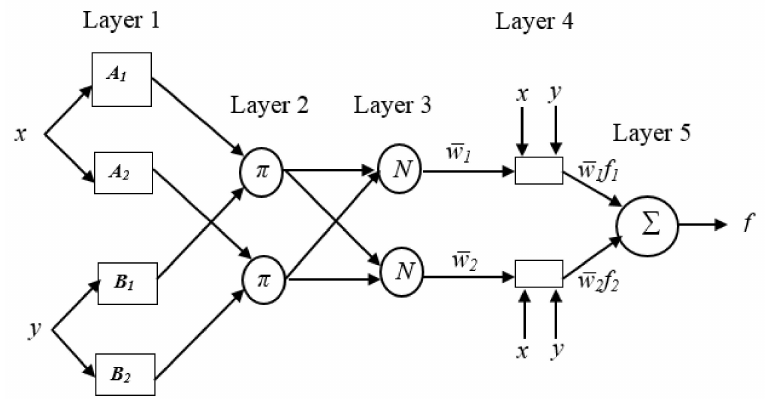
Figure 8. Adaptive Neuro-Fuzzy Inference System (ANFIS)